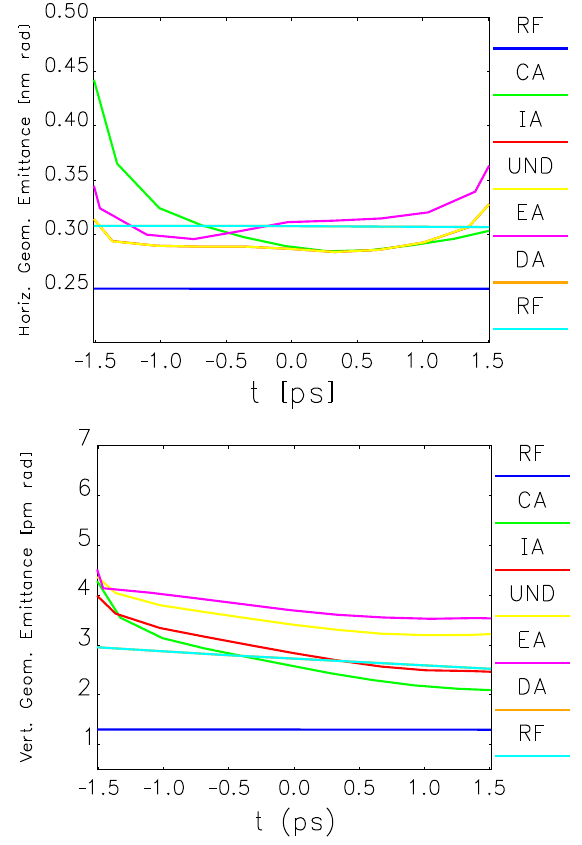
FIG. 4. Slice geometric emittance in the bunch core through one loop; labels refer to Fig. 1. In the top plot, the yellow line ( ε x at the exit of TGU) is superimposed to the red line (exit of IA). In both plots, the cyan line ( ε at the loop end) is superimposed to x;y the orange line (exit of decompressive